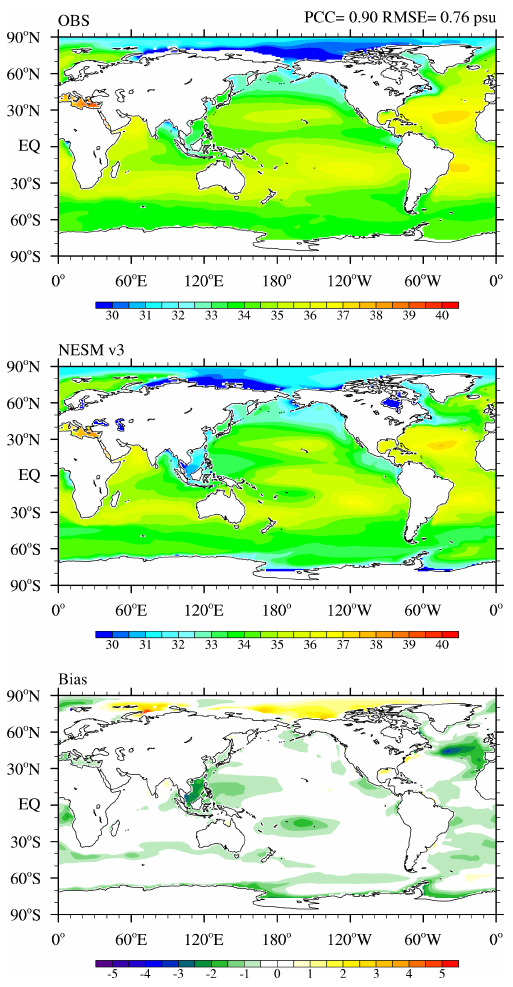
Figure 11. Same as in Fig. 9 except for the annual mean sea surface salinity (psu). The observed SSS data are from the World Ocean Atlas 2009 (WOA09; Locarnini et al., 2010). Figure 12. Climatological Arctic sea ice concentration in HadISST (a, b) , NESM v3 (c, d) , and model bias (e, f) for Febru- ary (a, c, e) and September (b, d, f) . The observed sea ice concen- tration is averaged over the period